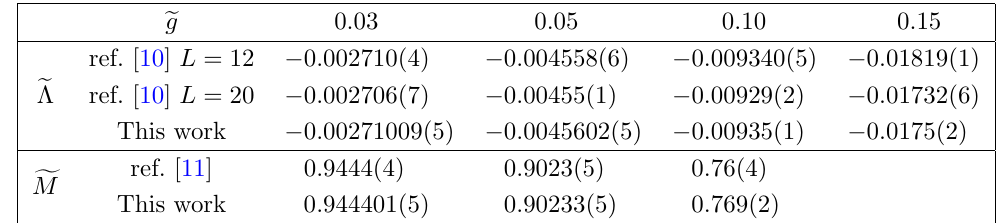
Table 5 . The values of